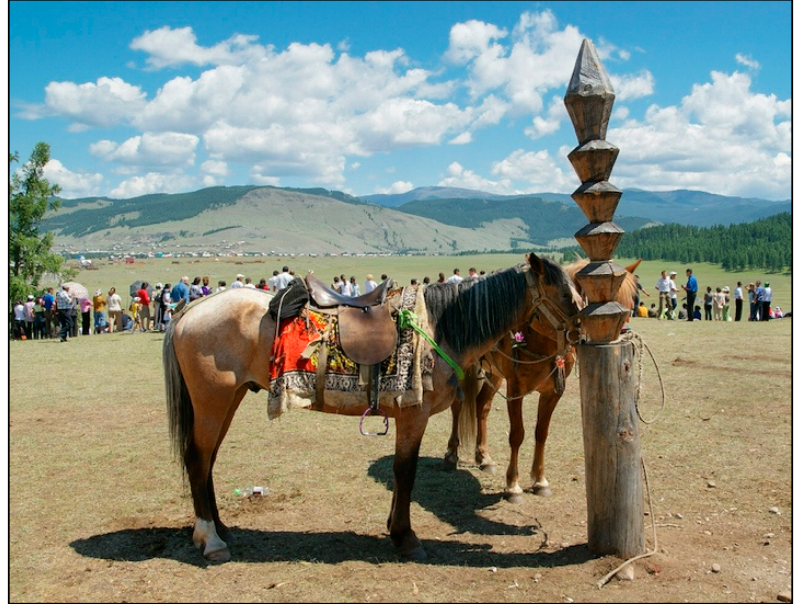
Figure 3. Horses fastened to a wooden hitchrack, central Altai. Photo: Andrzej Rozwadowski.